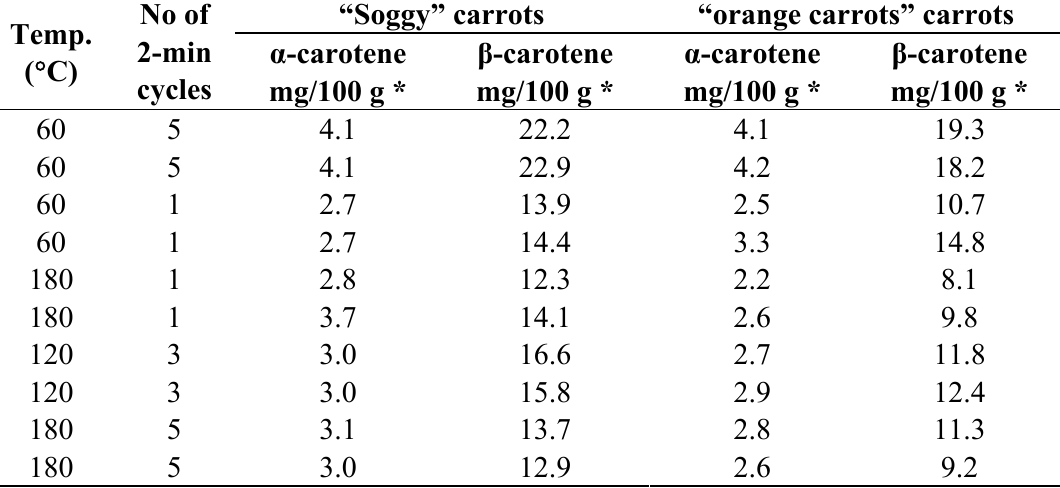
Table 1. Content α , β -carotenes in soft “soggy” and “orange carrots” extracted at different times and